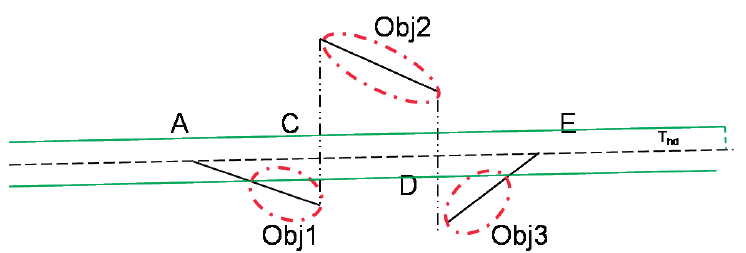
Figure 14. Cross-section of the dDSM obtained by using the proposed method, where the black dash line is the zero height difference. The two green solid lines represent the threshold of height difference. The height difference between the two green lines is set to zero (the absolute value of dDSM smaller than T hd is set to zero). Thereafter, Obj1, Obj2, and Obj3 are obtained by using the smoothness computation and connected component analysis